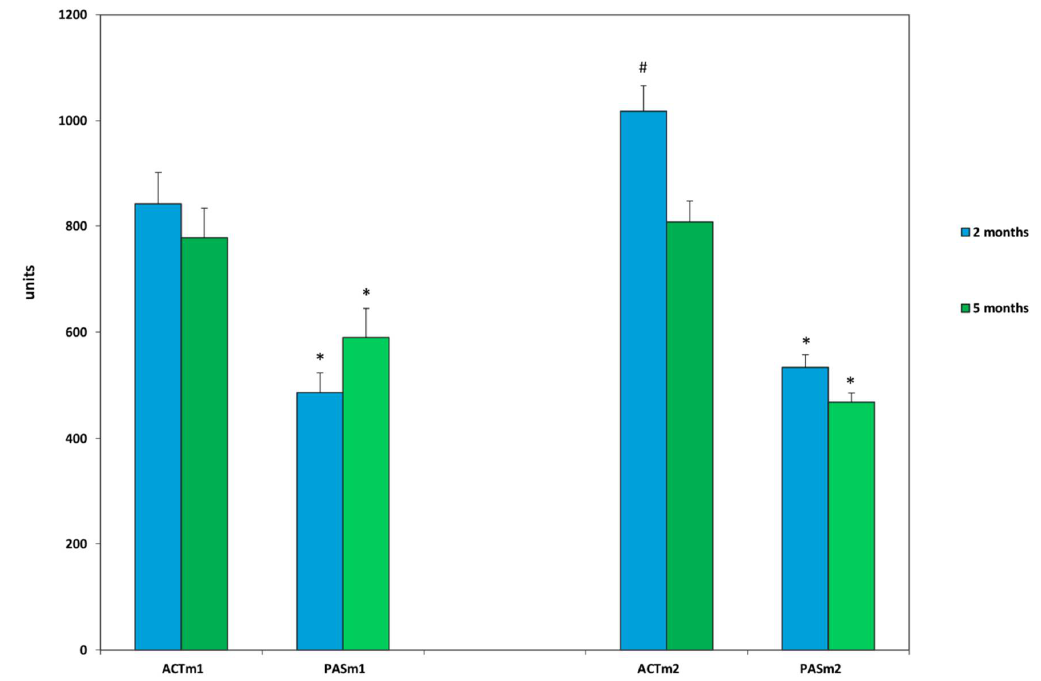
Figure 1. Total horizontal motor activity of male rats for 60 min. * p < 0.05 between ACTm and PASm; # p < 0.05 between ACT1 and ACT2.